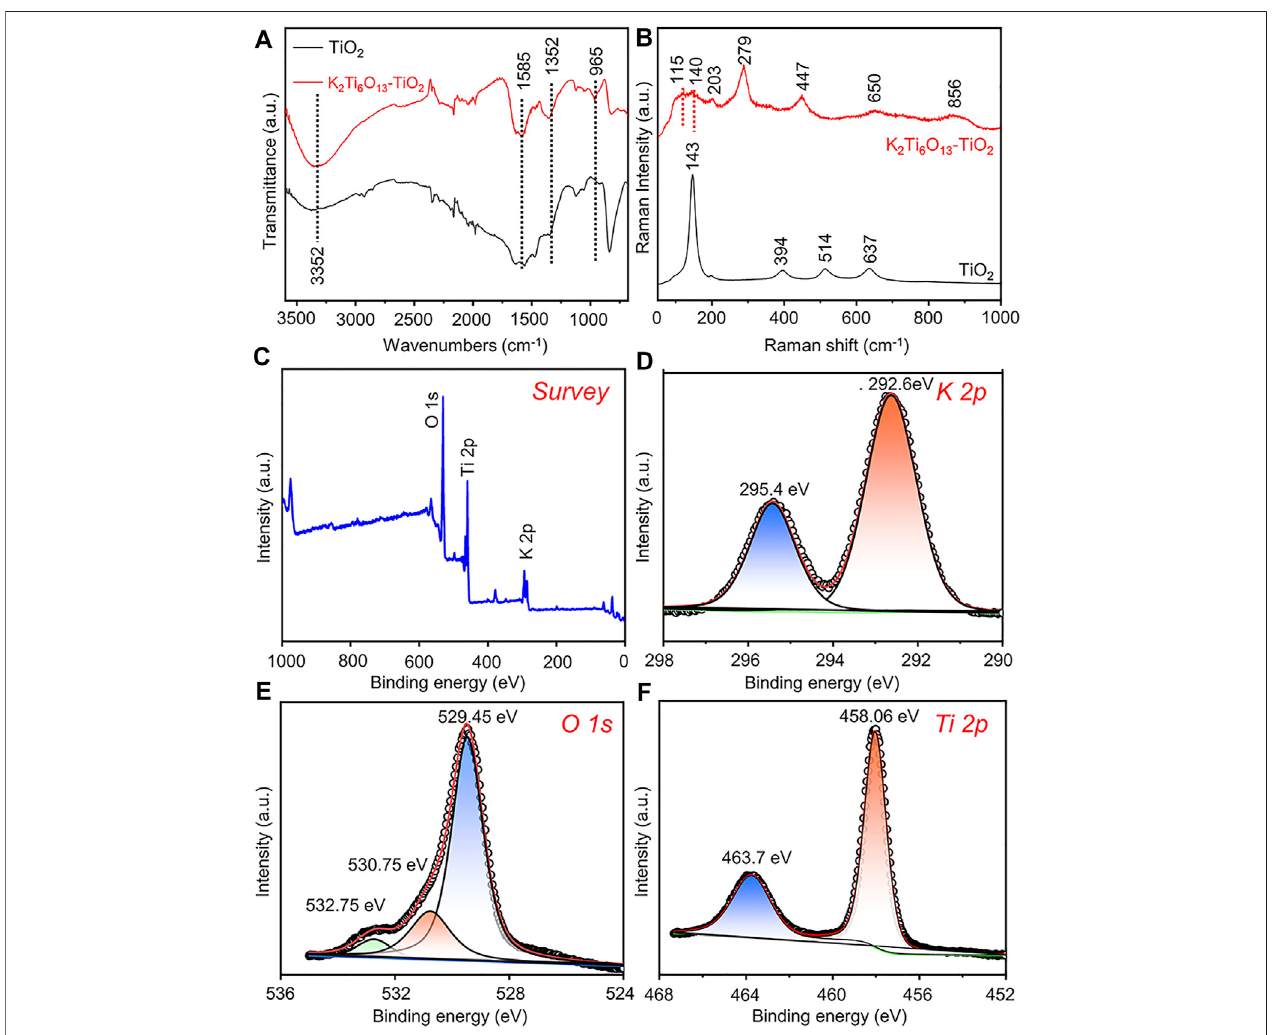
FIGURE2| CharacterizationofK 2 Ti 6 O 13 -TiO 2 hybridnanorodarraysandTiO 2 nanotube arrays. (A) FTIRanalysisofK 2 Ti 6 O 13 -TiO 2 hybridnanorodarraysandTiO 2 nanotubearrays. (B) RamanspectraofK 2 Ti 6 O 13 -TiO 2 hybridnanorodarraysandTiO 2 nanotubearrays.XPSspectraofK 2 Ti 6 O 13 -TiO 2 hybridnanorodarrays: (C) survey, (D) K 2p, (E) O 1s, and (F) Ti 2p